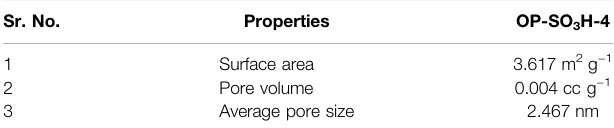
TABLE 2 | Textural properties of OP-SO 3 H-4. Sr.